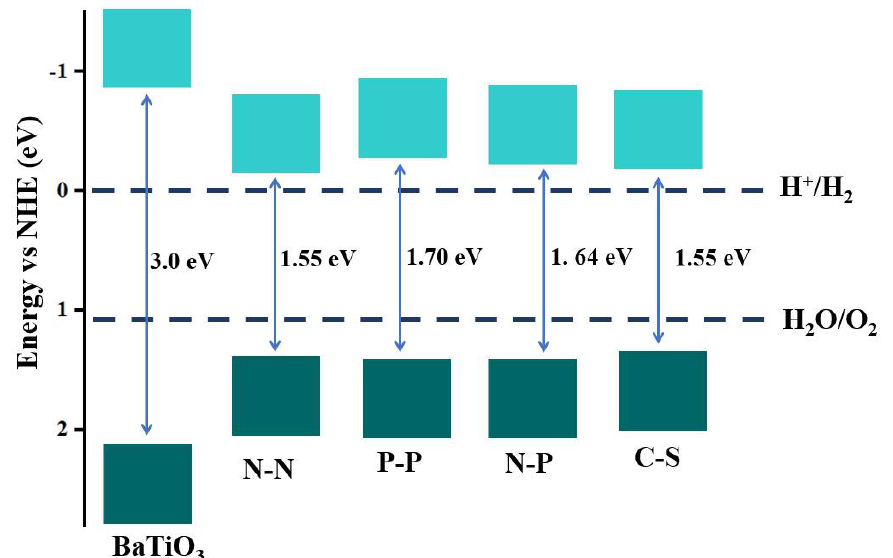
Figure 5. The calculated VB and CB edge energy levels versus normal hydrogen electrode (NHE) using HSE06 functional of N−N, P−P, N−P, and C−S co-doped BaTiO 3 .